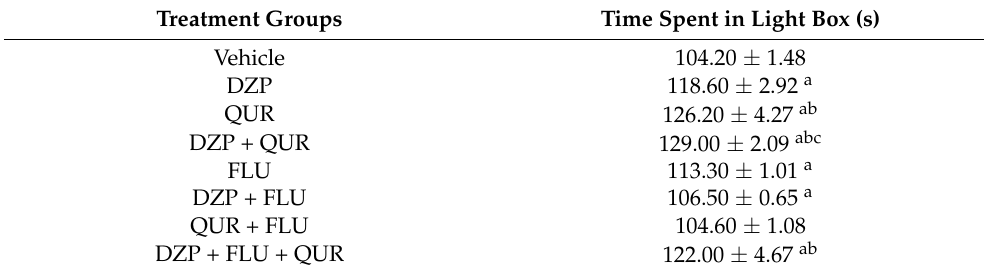
Table 4. The light residence time of the test animals pre-treated with the sample and controls (light–dark